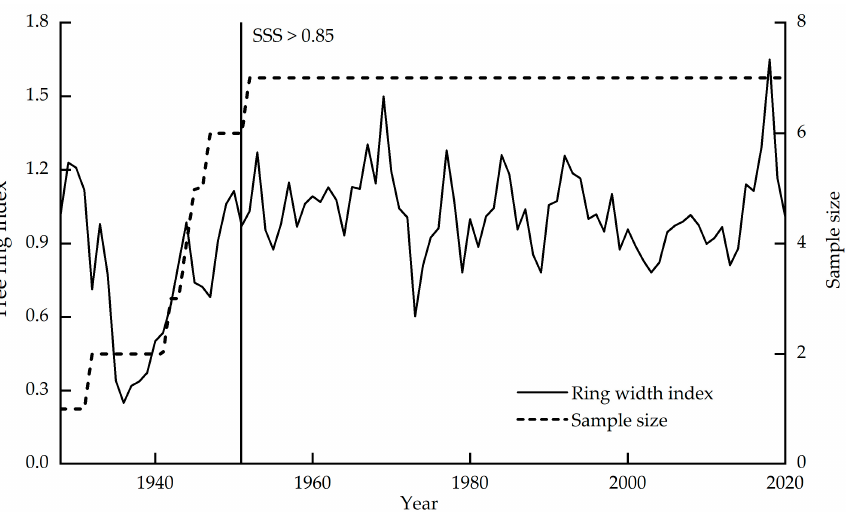
Figure 3. Standard chronologies and sample sizes of the annual ring widths of picea meyeri on Luya Mountain.